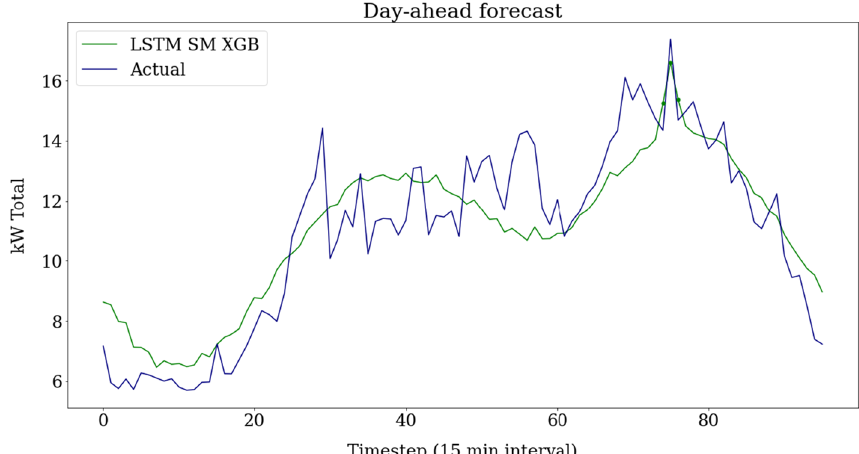
Fig. 5 Day-ahead forecast for 2019-10-16 with hybrid LSTM-XGBoost model. Peak load finetuning is conducted on timestep 75, marked with green dots. The overall forecasting accuracy in terms of MAPE is